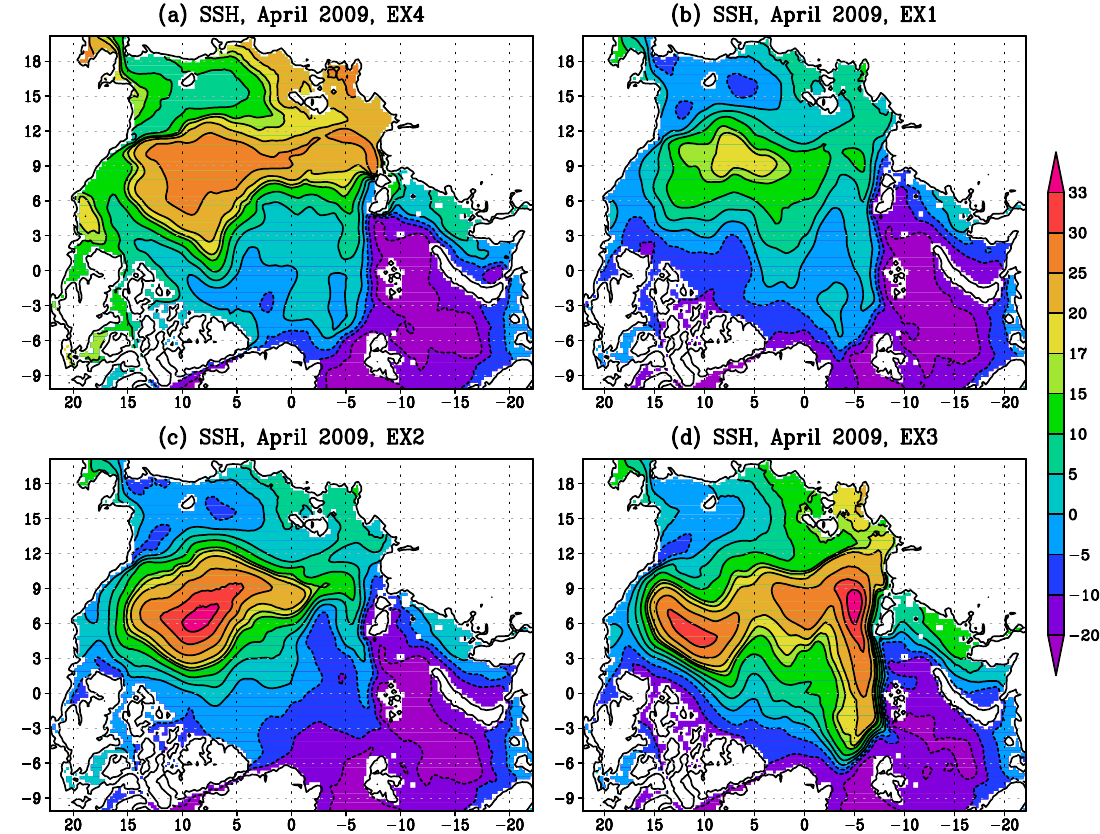
Figure 8. Sea surface height (in cm plus 30) in the EX4 ( a ), EX1 ( b ), EX2 ( c ) and EX3 ( d ) in April 2009 (The 62nd year of integration). April 2009 is the month of the maximum sea ice extent for the Arctic Ocean and Nordic Seas according NSIDC data. The model coordinates are used (see the caption under Figure 1, the point with coordinates (0,0) corresponds to the North